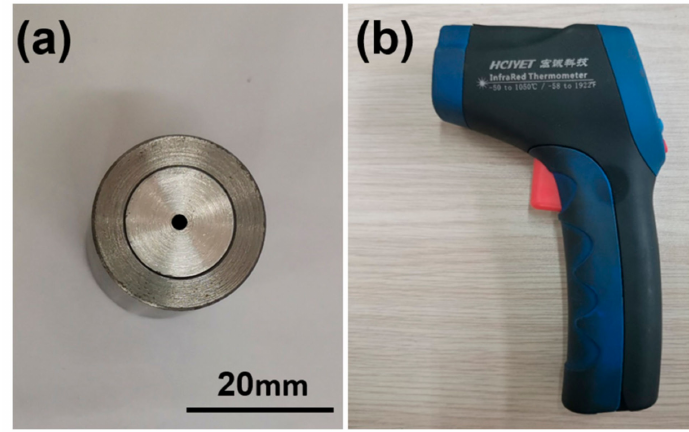
Figure 4. ( a ) Mark on aluminum core, ( b ) infrared thermometer.